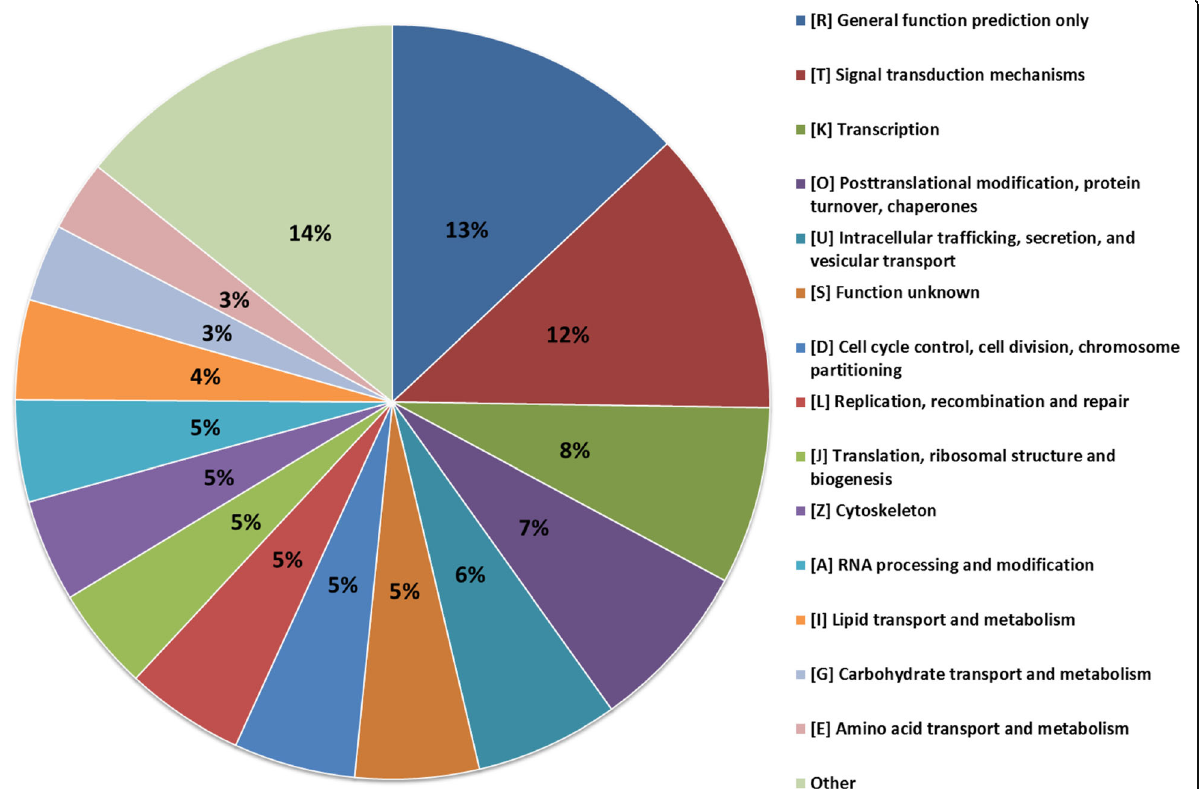
Fig. 5 Relative abundance of KOG functional annotations within predicted genes